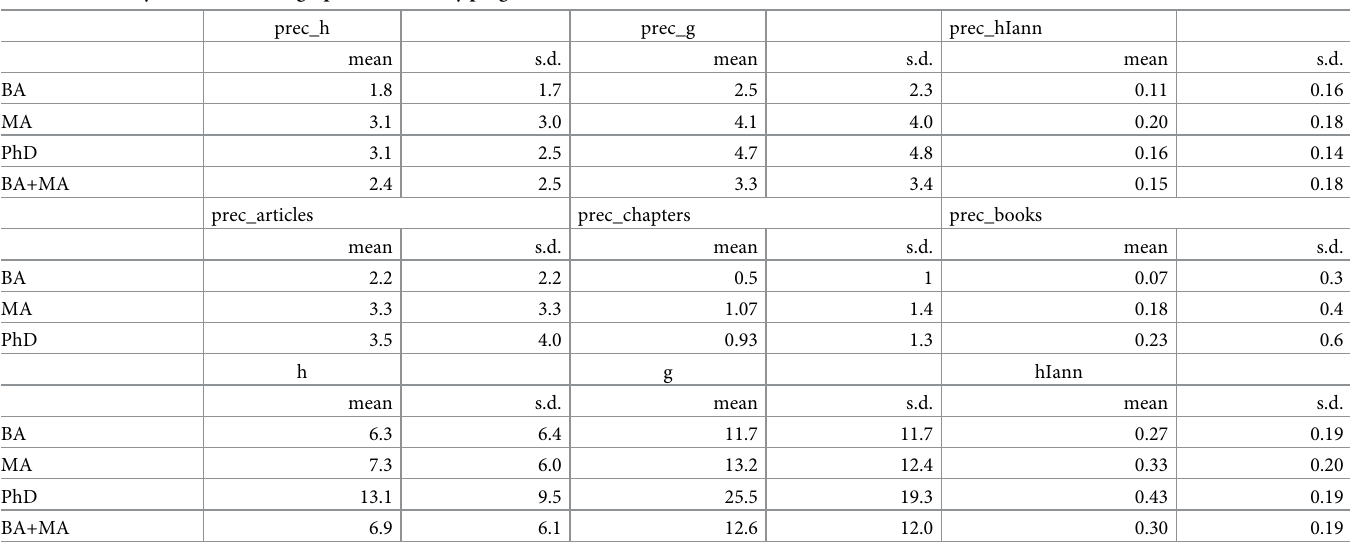
Table 1. Precocity and career bibliographic measures by program level.